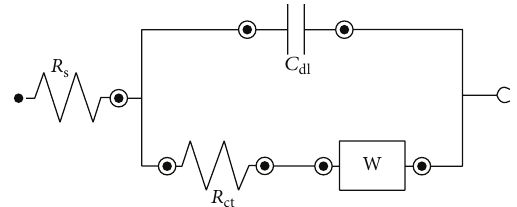
Figure 10: Warburg impedance simulation cell (equivalent circuit with mixed kinetic and charge transfer control).